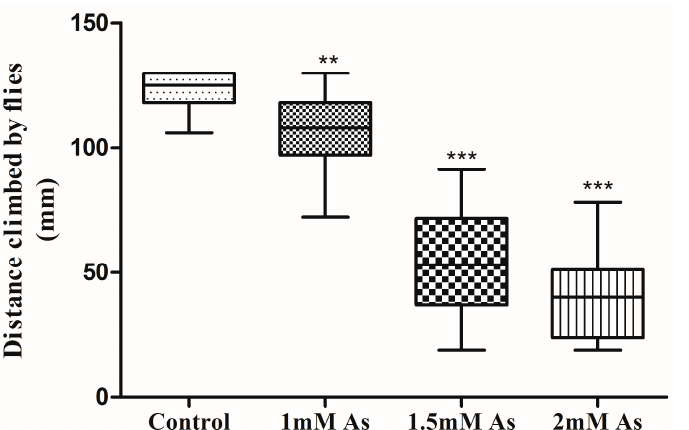
Figure 5. The box plot represents the negative geotaxis ability of adult flies treated at different con- centrations of arsenite compared to the control flies. The distance is measured in millimeters (mm). The upper bar displays the maximum value from the dataset, while the lower bar displays the min- imum value from the dataset. The significant mean difference ( p < 0.05) between the untreated and treated climbing ability was analyzed by a one-way analysis of variance (ANOVA) (** p < 0.01; *** p < 0.001; R square = 0.712).